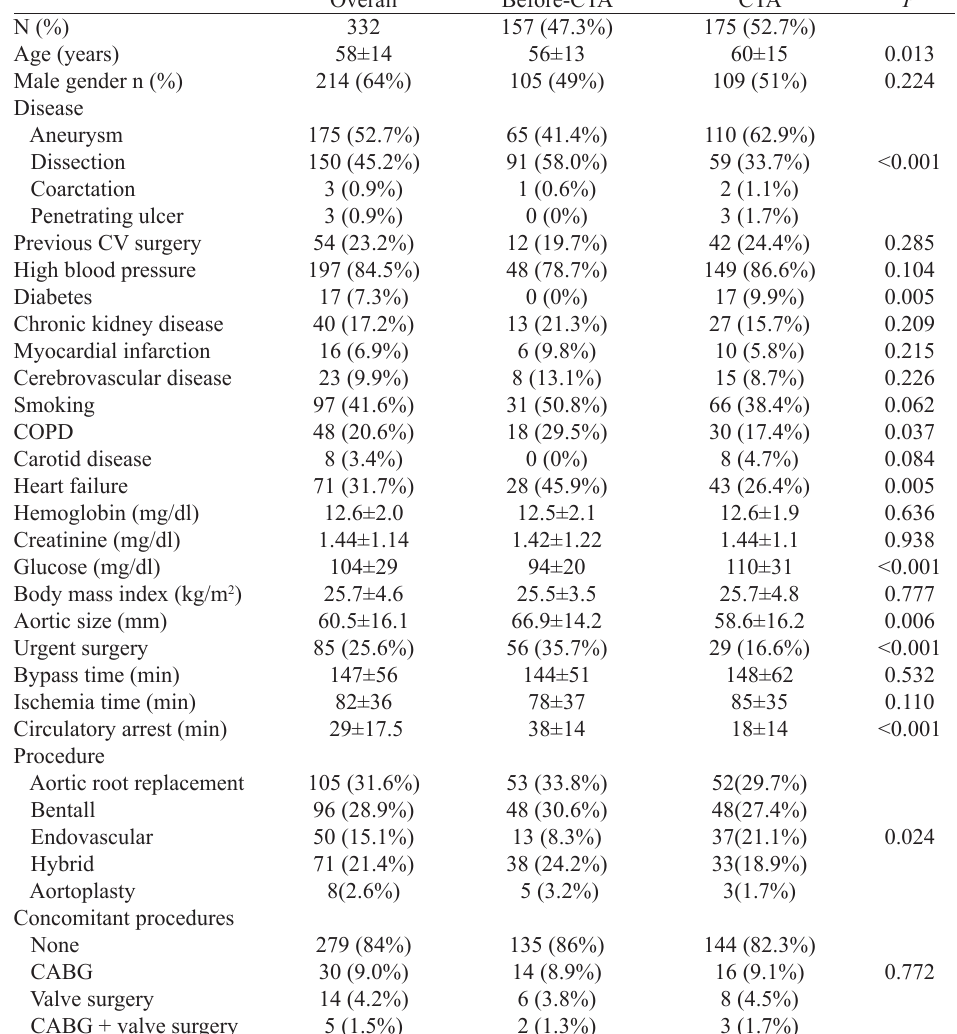
Table 1. Baseline clinical characteristics and operative variables according to the